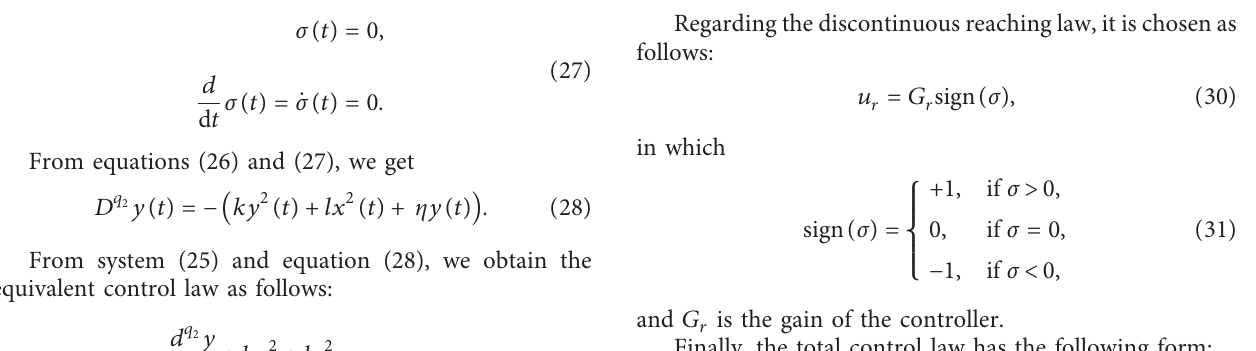
) of system (6) with order q max